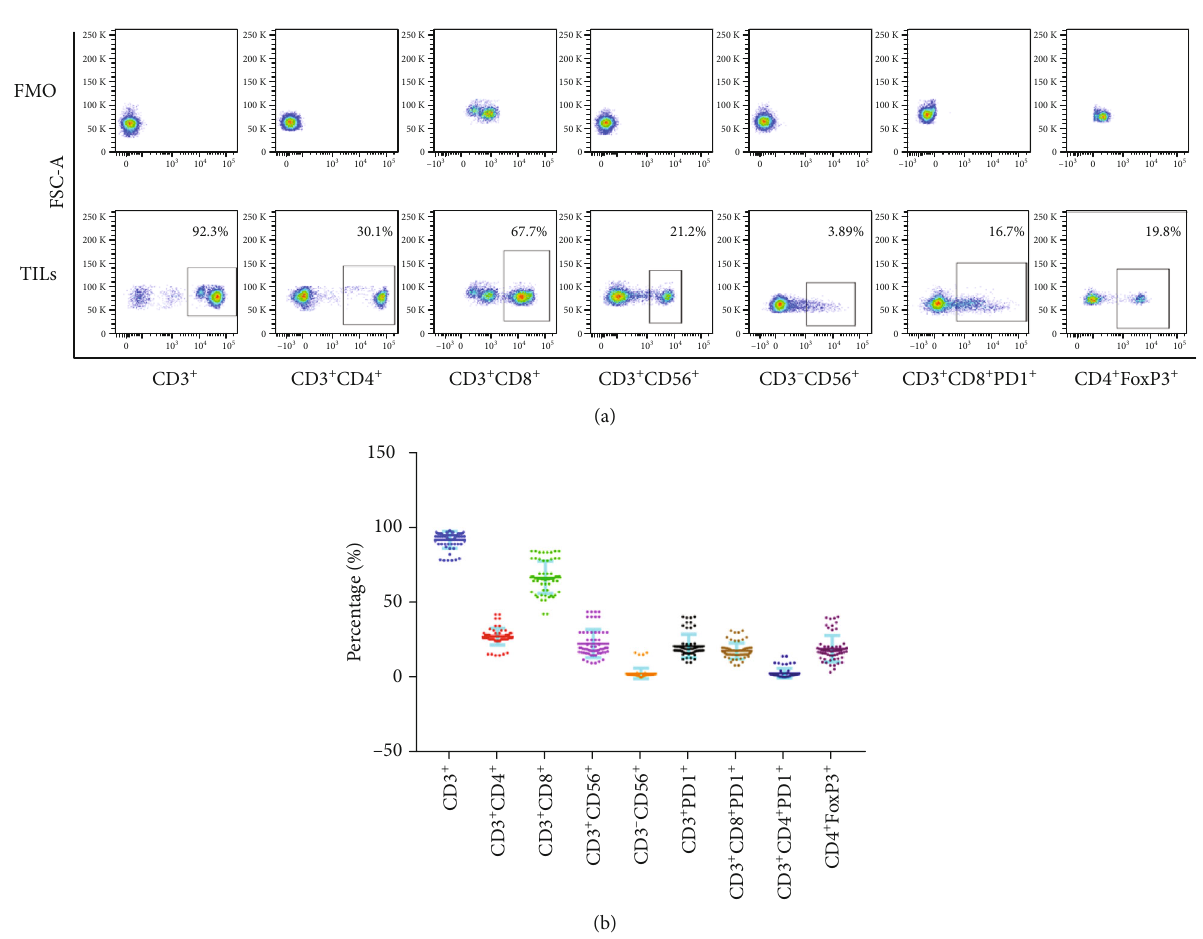
Figure 1: Phenotype of TILs at the time of infusion. (a) Representative fl ow cytometry of CD3 + , CD3 + CD4 + , CD3 + CD8 + , CD3 + CD56 + , CD3 - CD56 + , CD3 + CD8 + PD1 + , and CD4 + FoxP3 + percentage of TILs. (b) Quantitative analysis of CD3 + , CD3 + CD4 + , CD3 + CD8 + , CD3 + CD56 + , CD3 - CD56 + , CD3 + PD1 + , CD3 + CD8 + PD1 + , CD3 + CD8 + PD1 + , and CD4 + FoxP3 + percentage of TILs. FMO is negative control. Table 2: Treatment-related adverse events in patients in response to therapy ( N = 60